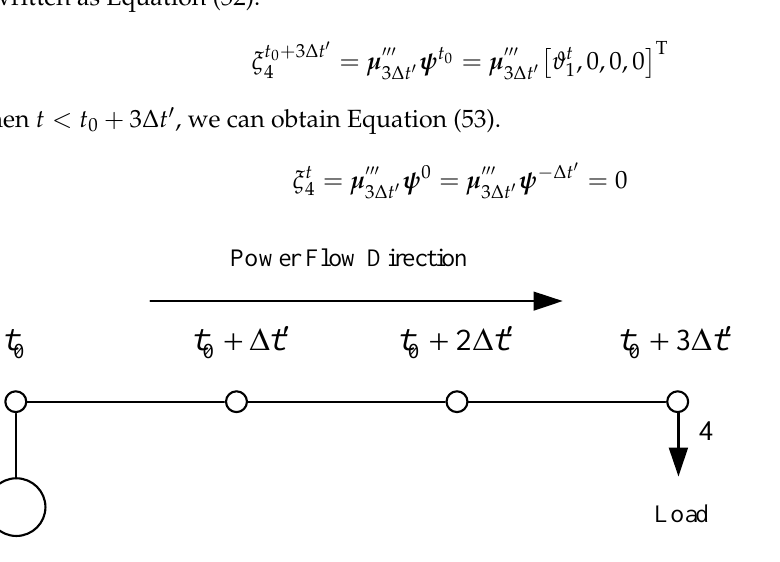
Figure 4. Special branch in the IES.